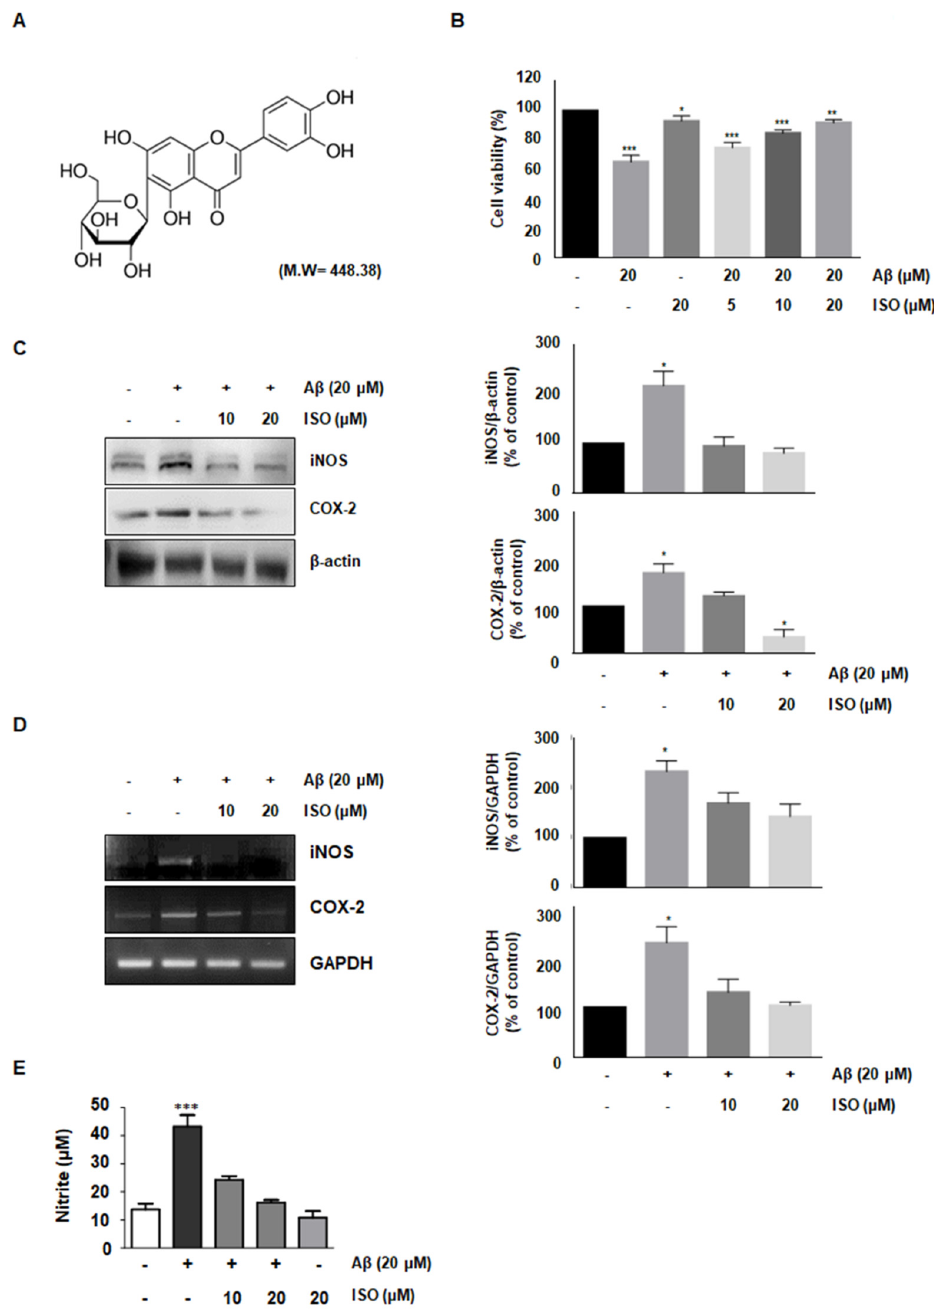
Figure 1. ISO reverses the cytotoxic effects of A β 25–35 in BV2 cells. ( A ) Structure of isoorientin (ISO) ( B ) BV2 cells (1 × 10 4 cells/mL) were treated with the indicated concentrations of ISO (0, 5, 10, 20 μ M) 1 h before A β 25–35 (20 μ M) treatment for 24 h. Cell viability was assessed by CCK-8 assays and the results are expressed as a percentage of surviving cells over control cells. Results are representative of those obtained from three independent experiments. ( C ) BV2 cells were pretreated with different concentrations of ISO as indicated 1 h before the addition of A β 25–35 (20 μ M) for 24 h. The protein levels were observed by Western blotting analysis. ( D ) The mRNA levels of iNOS and COX-2 were determined by the RT-PCR in BV2 cells. ( E ) BV2 cells were pretreated with different concentrations of ISO as indicated 1 h before the addition of A β 25–35 (20 μ M) for 24 h. Cell culture media were harvested for the measurement of nitrite (NO). The experiments were repeated more than three times and similar results were obtained. Data indicate mean ± SEM of three independent experiments. * p < 0.05, ** p < 0.01, *** p < 0.001 versus control.